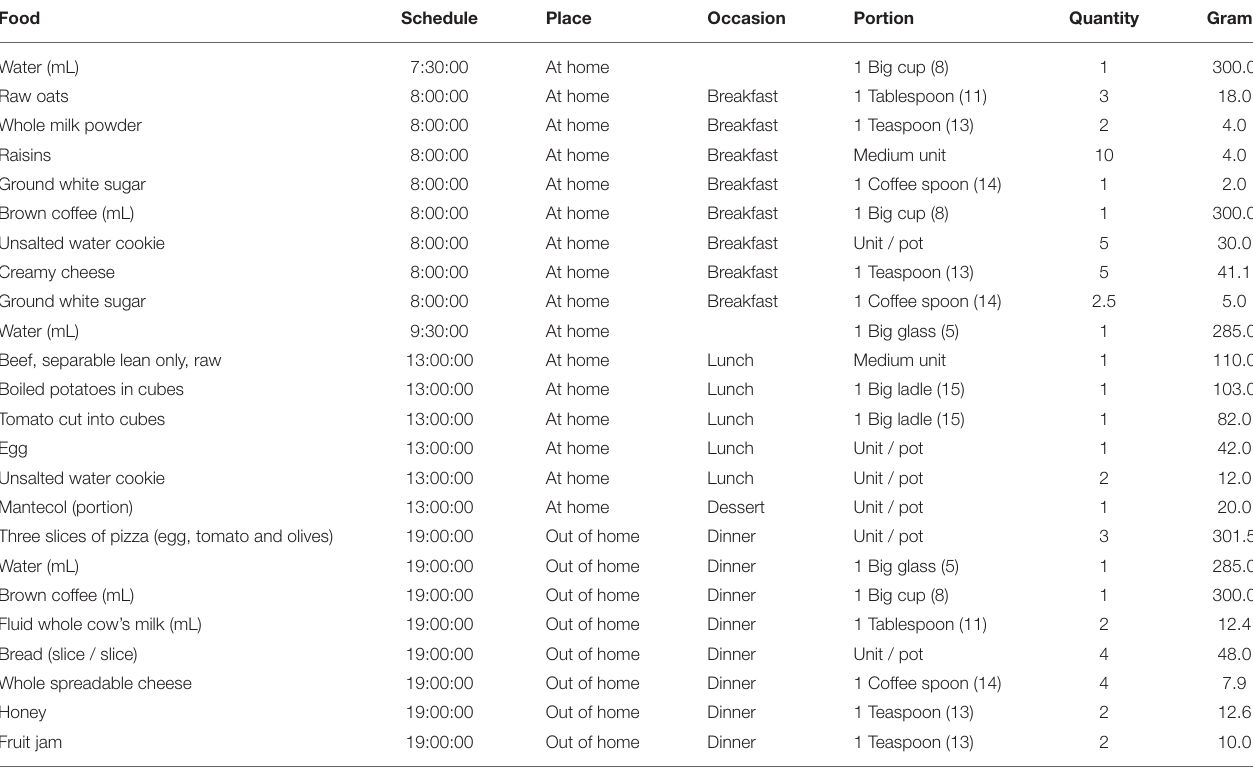
TABLE 2 | Sample of food list from a 24HR loaded into